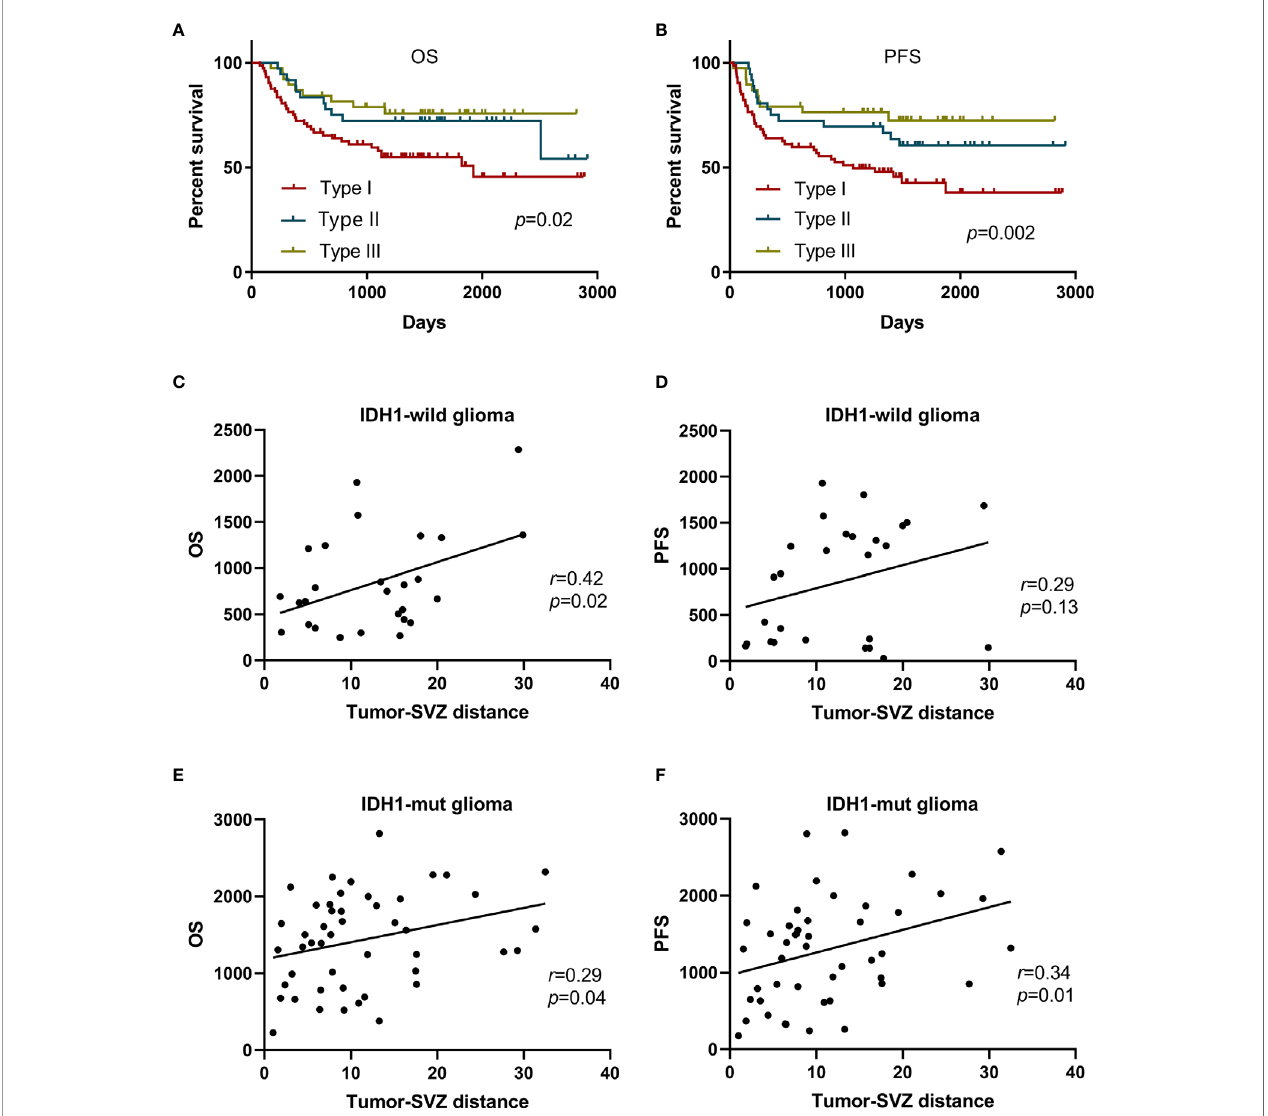
FIGURE 2 | Kaplan-Meier curve analysis of all patients and simple linear correlation analysis of patients with non-SVZ-contacting glioma. Kaplan-Meier curves plotting of patient OS (A) and PFS (B) strati fi ed by the tumor-SVZ distance. Simple linear correlation between the OS and tumor-SVZ distance in IDH1-wild glioma (C) and IDH1-mut glioma (E) . Simple linear correlation between the PFS and tumor-SVZ distance in IDH1-wild glioma (D) and IDH1-mut glioma (F) . Type I means SVZ involvement, type II means tumor-SVZ distance from 0 to 10 mm, type III means tumor-SVZ distance >10